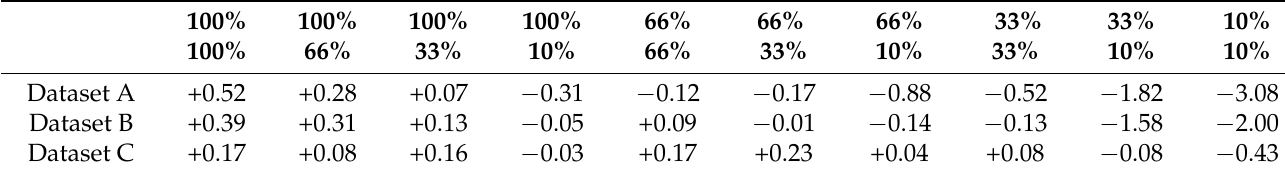
Table 10. D K with various breakdowns of